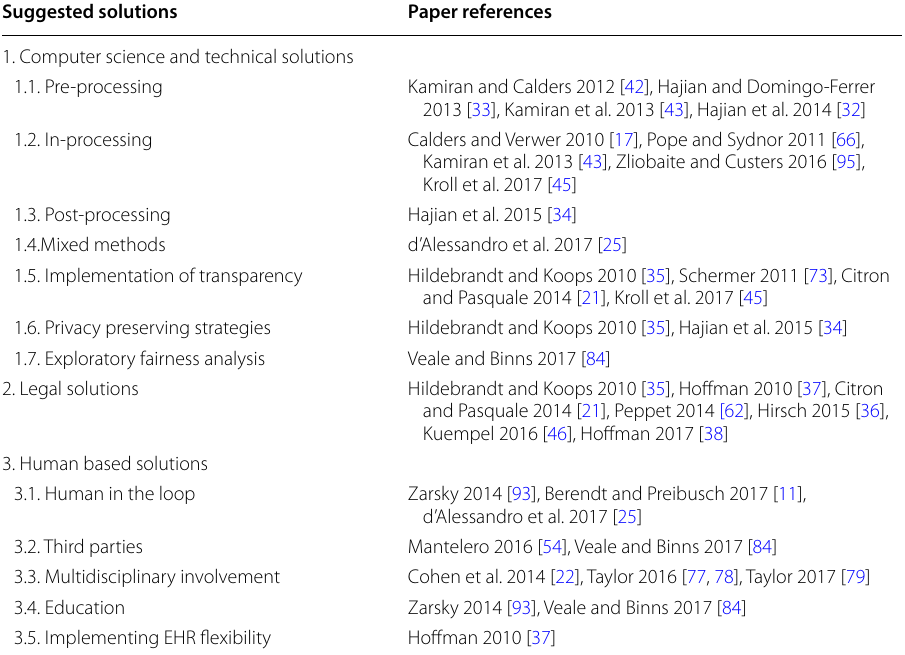
Table 5 Suggested solutions to discrimination in Big Data Suggested